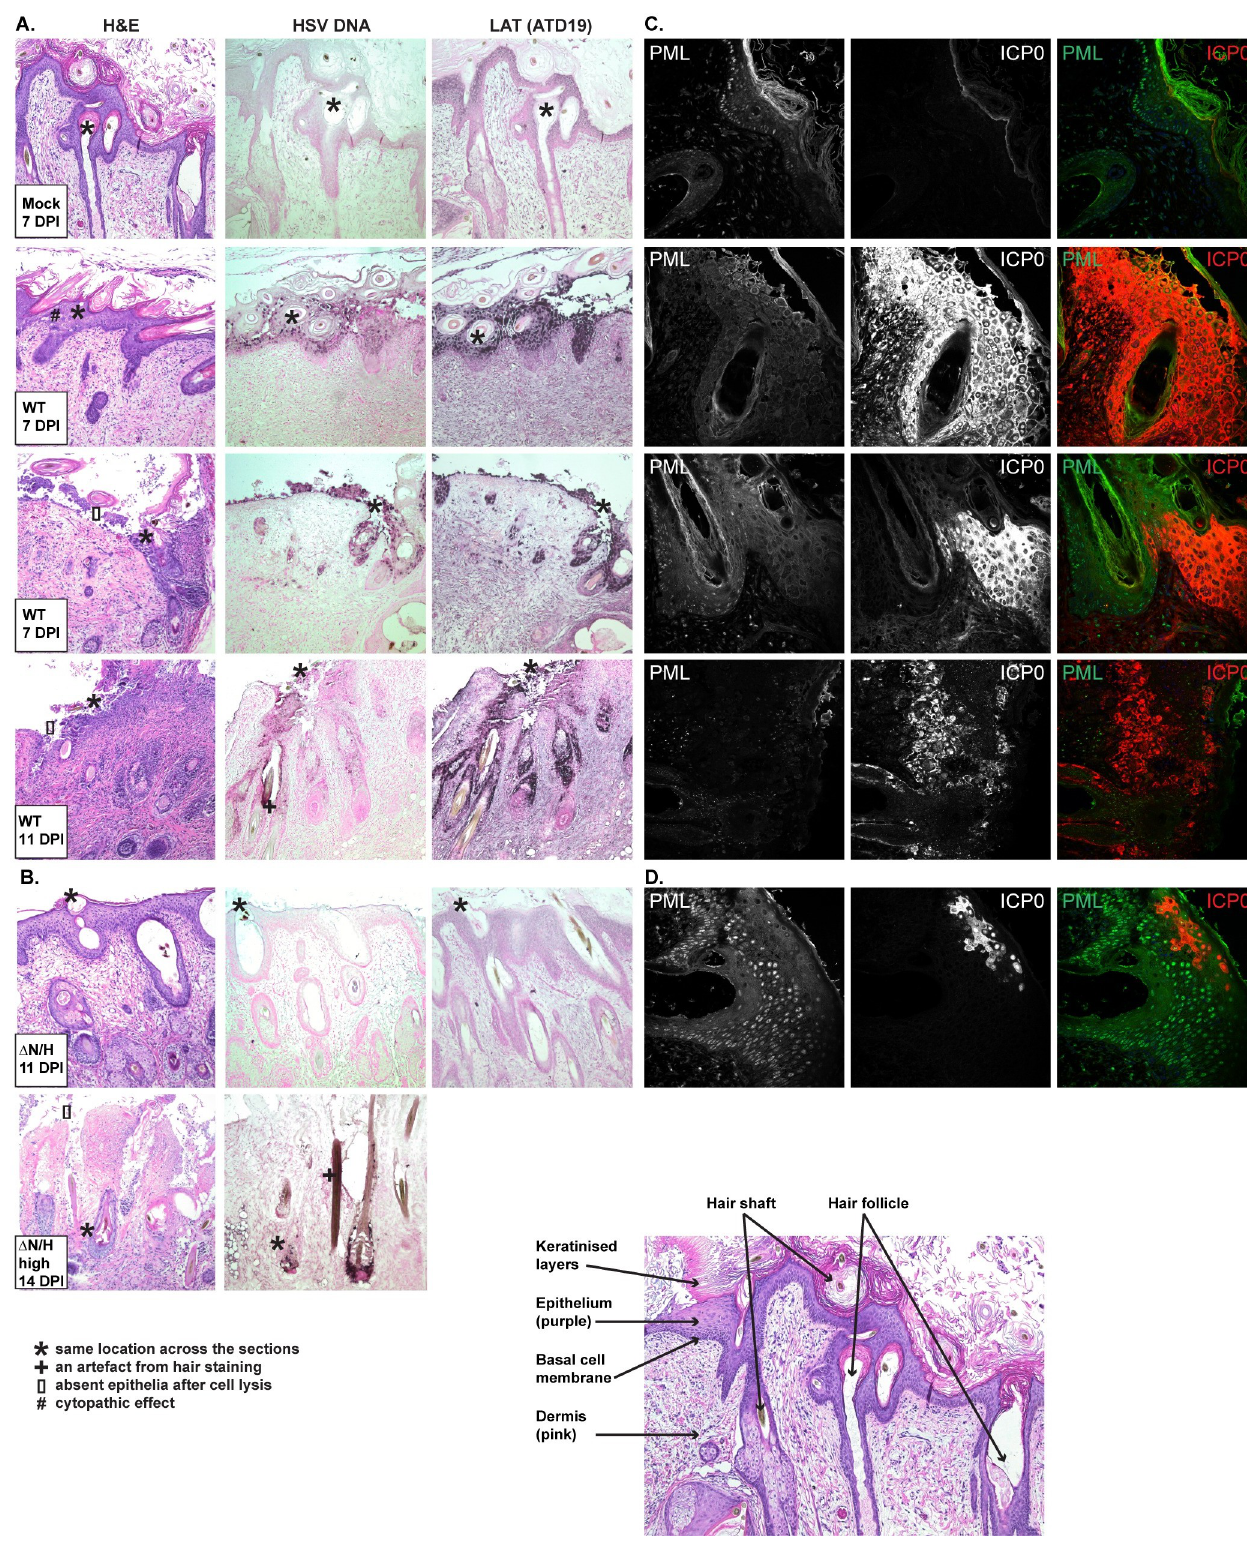
Fig 2. Cutaneous lesion formation by 17 syn + and 17 Δ N/H in human skin in vivo . (A) Representative mock- and 17 syn + -infected (2,500 PFU) skin sections at 7 or 11 DPI stained with haematoxylin and eosin (H&E; left), and in situ hybridisation for HSV-1 DNA (centre) or LAT using ATD19 probe (right). (B)